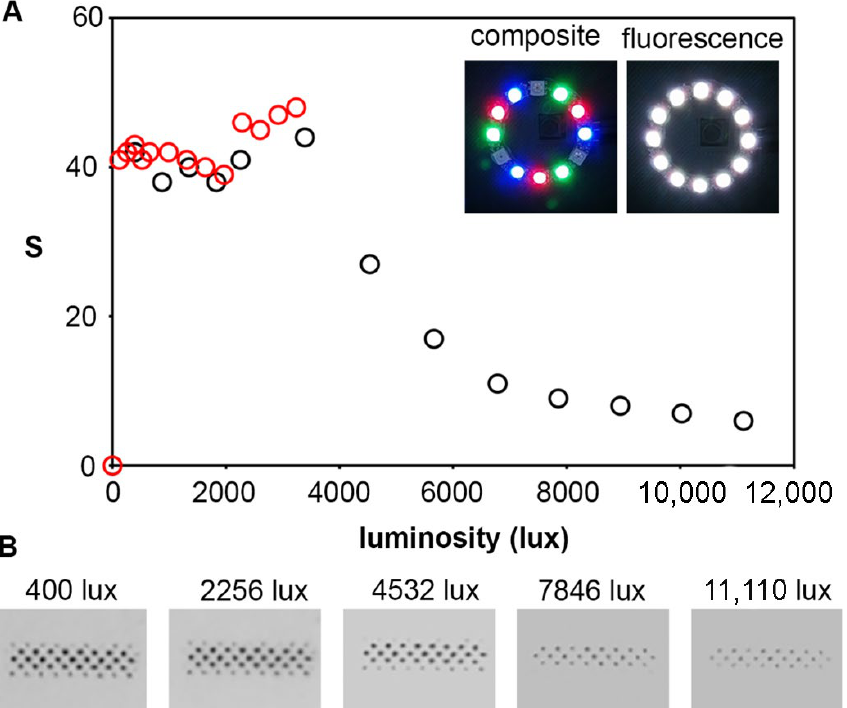
Figure 2. Impact of luminosity in imaging conditions using composite white light with and without fluorescence (shown in inset): ( a ) Impact of light intensity (lux) on densitometric signal S with fluorescence (black) and without fluorescence (red); ( b ) Photographs of the same calibrator taken with fluorescence at different luminosity values.